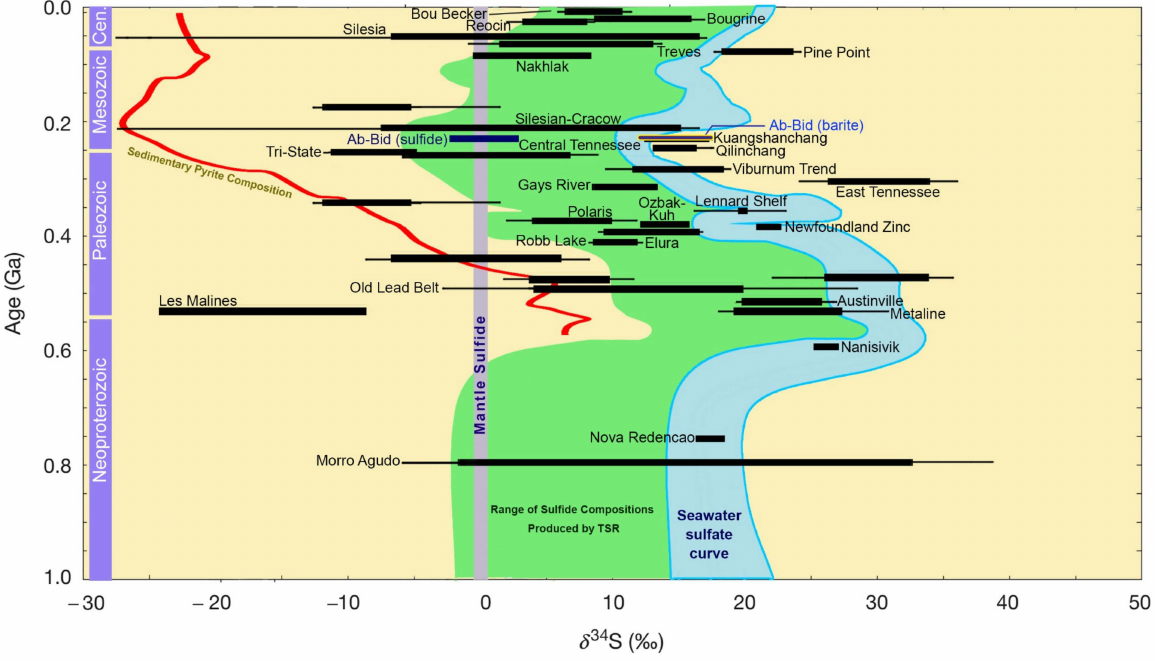
Figure 16. Diagram illustrating the range of δ 34 S values in sulfides and barite of the Ab-Bid deposit in comparison with the range and median δ 34 S values of sulfides in a selection of orogenic-related MVT deposits (data from [2,3,20–25]), seawater sulfate curve [26], mantle sulfide, and mean sedimentary pyrite composition (red line) as produced by bacterial sulfate reduction (BSR) [22]. The green-shaded field indicates the likely range of sulfide compositions produced by thermochemical sulfate reduction (TSR) of seawater-derived sulfate at 150 ◦ C [27]. Sulfur in most MVT deposits, in addition to the Ab-Bid deposit, is consistent with an origin from seawater sulfate, reduced by